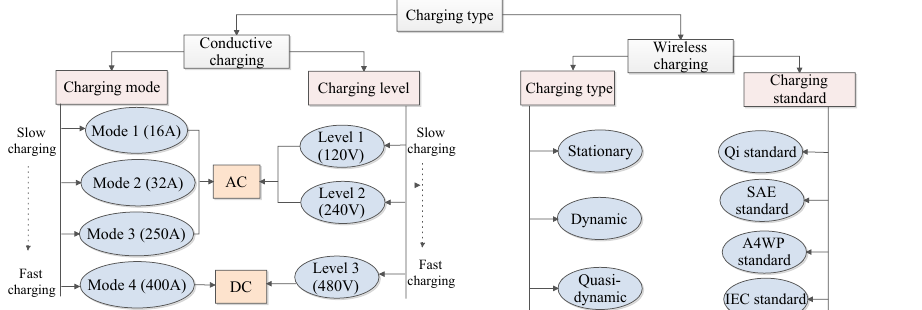
Figure 2. Conductive and wireless charging for EVs.